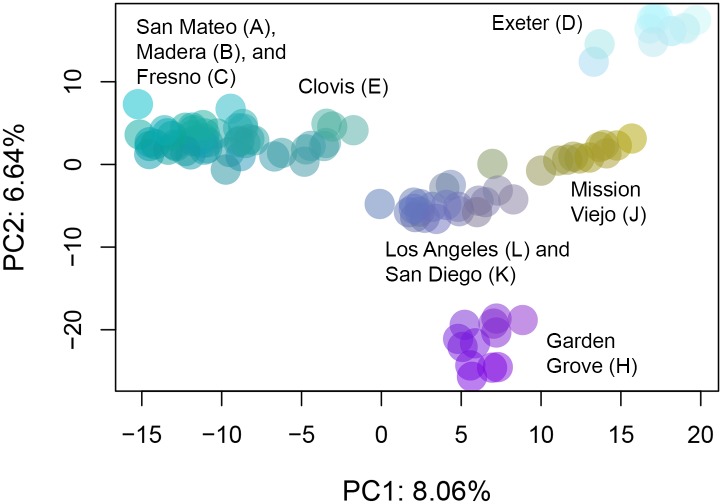
Population structure of California populations using SNP data and Principle Component Analysis.Data were transformed using PCA and plotted as a function of the first two principle components.